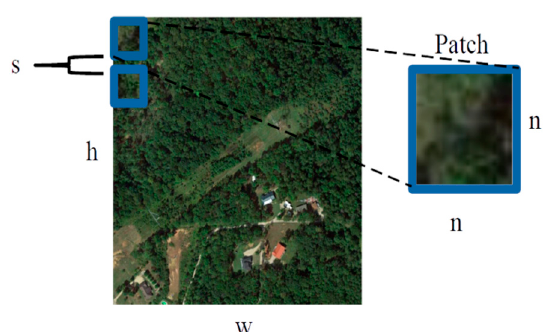
Figure 10. The process of patch creation where n is the patch width and height, w is the image width, h is the image height, and s is the step between patches.